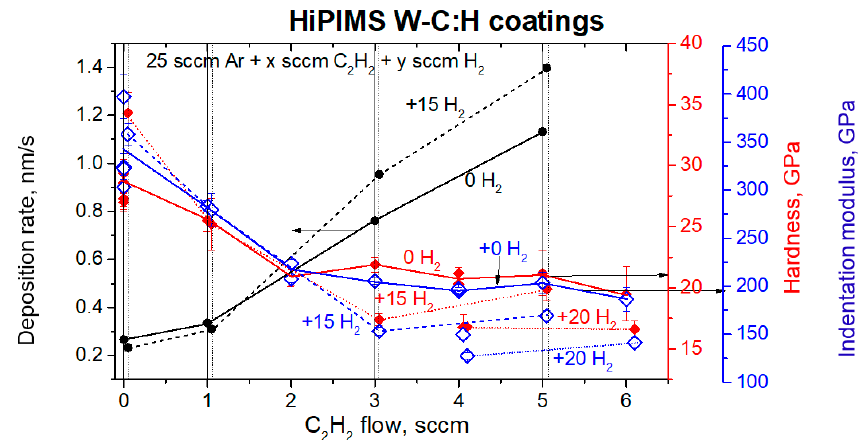
Figure 4. Summary of the deposition rates, hardness and indentation moduli of the studied (marked by the vertical lines) and earlier hybrid PVD–PECVD HiPIMS W-C:H [21,22] coatings in dependence on the additions of acetylene (full lines) and hydrogen (broken lines). A small offset was introduced for the data with hydrogen additions for better visibility.